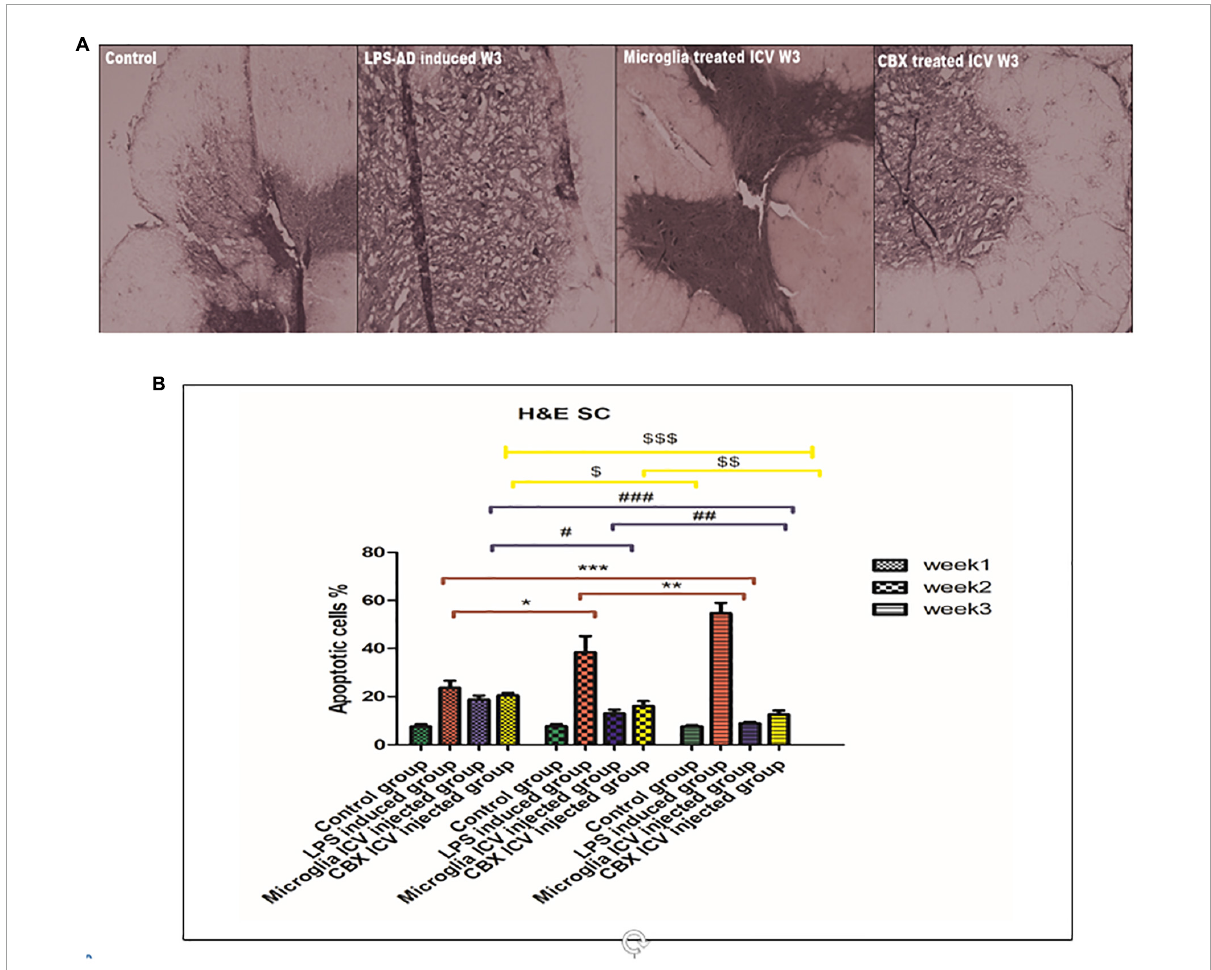
FIGURE8 Histopathological examination and assessment of the spinal cord stained H&E sections of the lipopolysaccharide (LPS)-induced rats and following the single intracerebroventricular (ICV) administration of primary healthy microglia (PHM) and carbenoxolone (CBX) (week 3). (A) Detection of the spinal cord-stained sections in the control, LPS-induced group, PHM-treated group, and CBX-treated group (week 3). (B) Percentage of apoptotic cells histogram over the 3-week time interval. Represented data were expressed as mean ± SD ( n = 6 per group) (ANOVA, repeated measurement, Bonferroni post-hoc test, p < 0.05). The same asterisks represent an insignificant difference p >